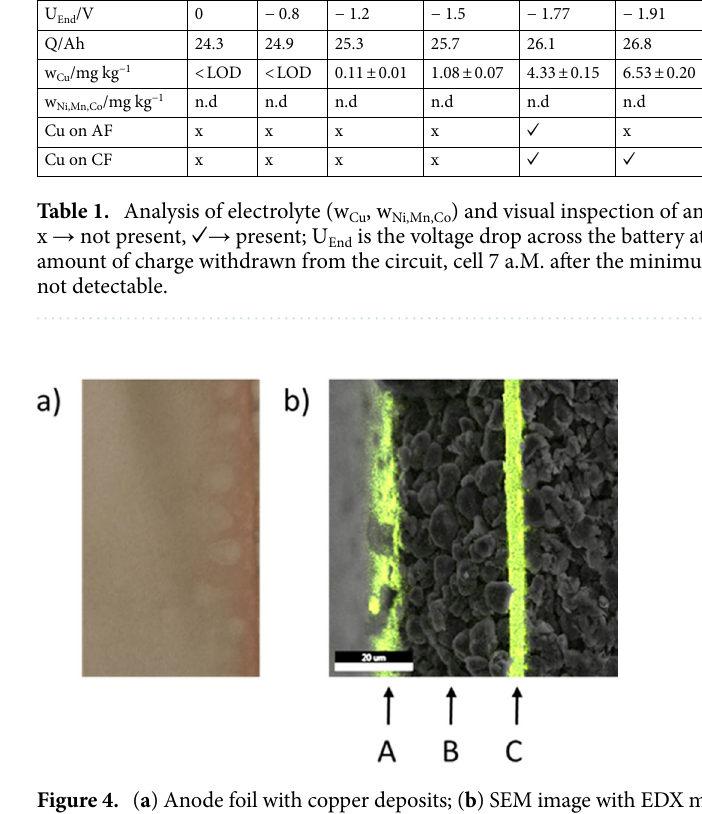
Figure 4. ( a ) Anode foil with copper deposits; ( b ) SEM image with EDX mapping superimposed on the cross- section of the anode foil, A: superficial copper layer, B: graphite layer, C: Cu carrier foil; U = − 1.77 V, Q = 26.1